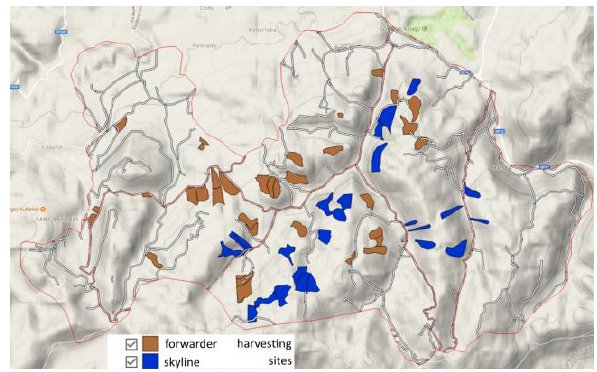
Figure 2. Location of harvesting sites used for training and validation, divided by wood harvesting approach.